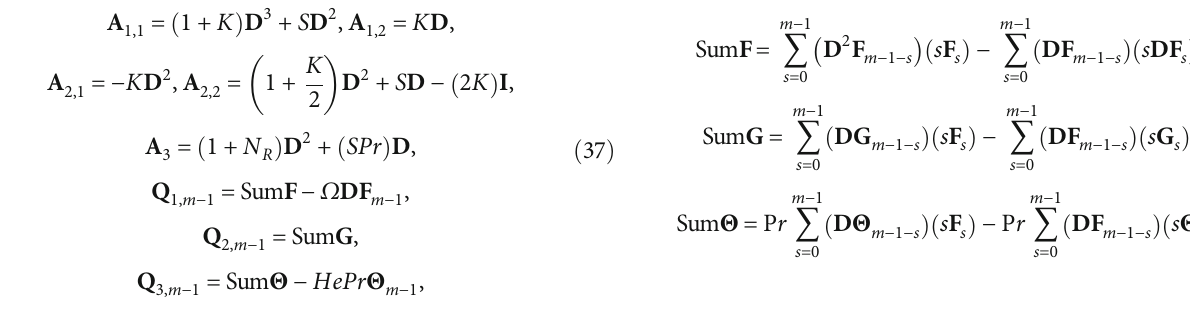
Figure 29: Variation of the LSPM numerical solution Θ = 0 : 6, Ω = 0 : 1, andHe = 0 : 2 0 : 5, Pr = 10, S = 3, N R